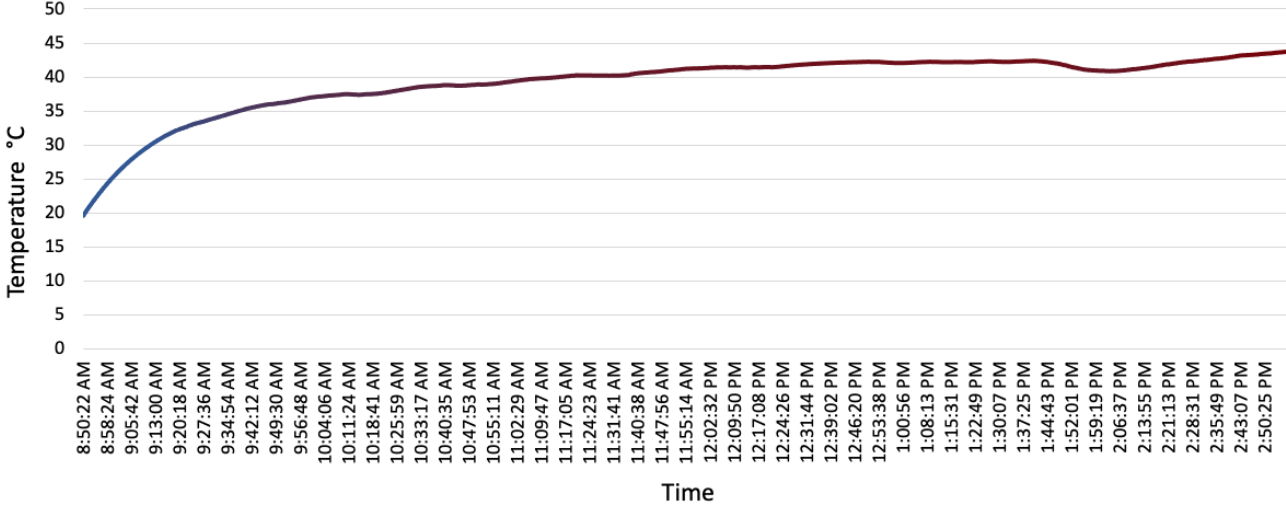
Figure 7. Gas analyser operating temperature during the